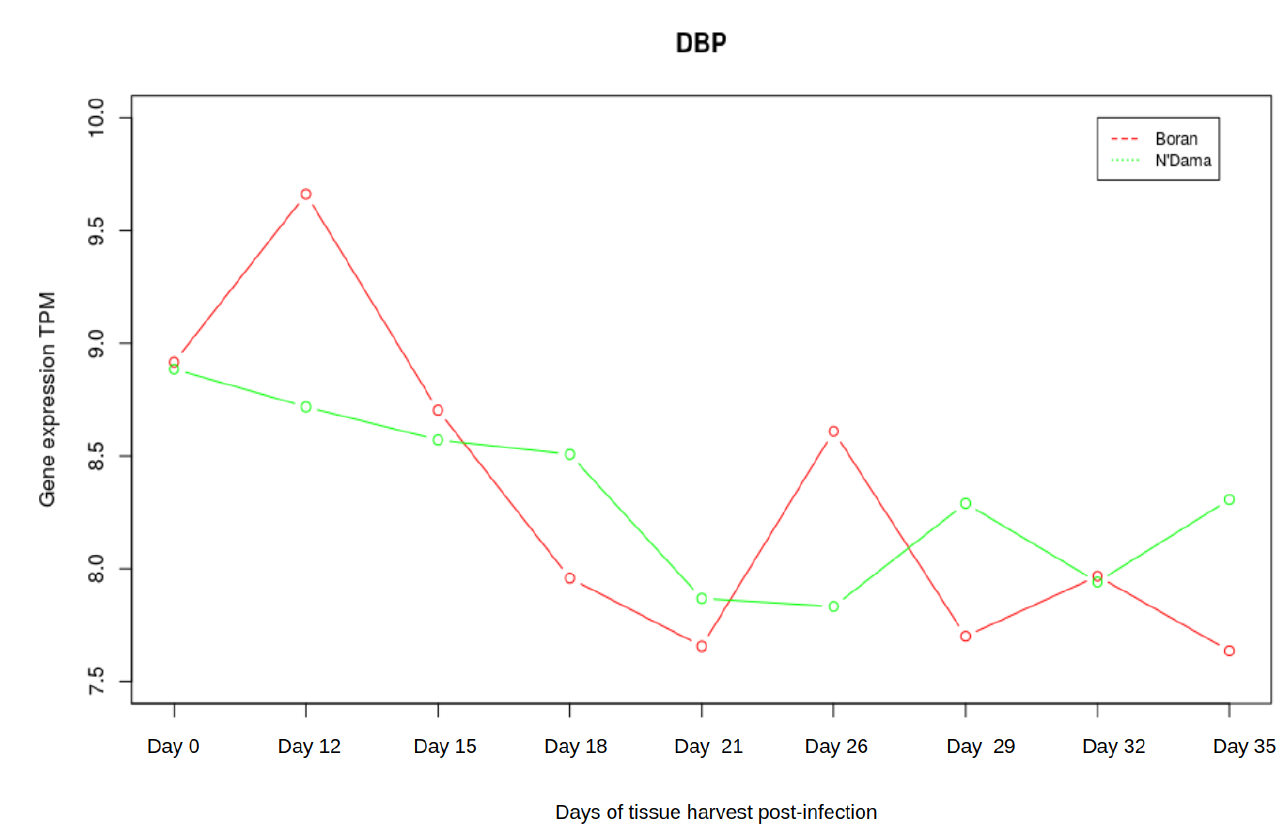
Figure 6. Expression of DBP . The red line in the plot corresponds to Boran whereas the green line corresponds to the breed N’Dama. In the early timepoints, expression of DBP reaches a peak in Boran and then starts to drop down. After the timepoint 5, the curve again increases slightly and at the later stages, it falls down again. On the other hand, the expression of DBP in N’Dama steadily drops until the timepoint 5, then it gradually